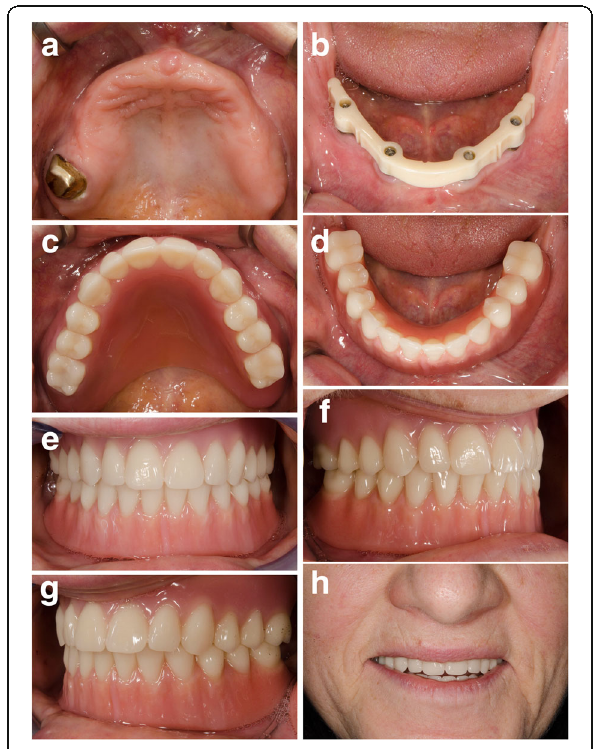
Fig. 4 a – h Prosthetic restauration — follow-up examination. Intraoral and perioral views of a rehabilitated female patient. (She asked explicitly only for implantological treatment in the